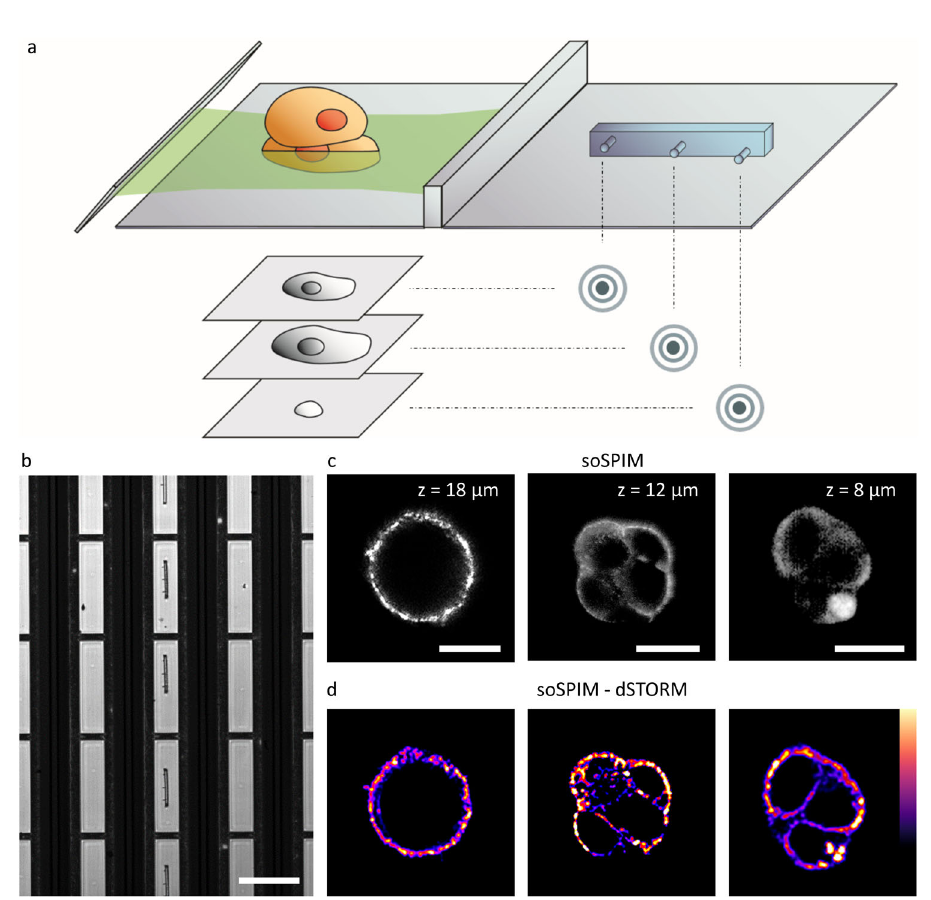
Fig. 4 3D focus locking for super-resolution single-objective selective-plane illumination microscopy over cellular volumes. a Laser light is re fl ected off a 45° mirror selectively illuminating a single plane within the sample. Fluorescence is captured via the same objective. Focus locking onto different axial planes is performed by using the 3D fi ducial. b Bright fi eld image of 3D fi ducial structures (shown schematically in Fig. 2c), taken with a x10 objective, located within individual wells of the soSPIM imaging chambers (central column) ( n = 7 chambers). Scale bar = 200 µ m. c soSPIM optical sections showing the distribution of CD47 labeled with Alexa-Plus 647 in HEK293 cells at the indicated depths ( n = 6). d Corresponding dSTORM images of CD47 at the depths shown in ( c ) ( n = 6). Scale bar = 5 µ structures were written layer-by-layer with 100 nm slicing distance between the individual layers. Computer-aided design of the fi ducial structures were produced using Autodesk fusion 360 and exported as stereolithography (.STL) fi les.